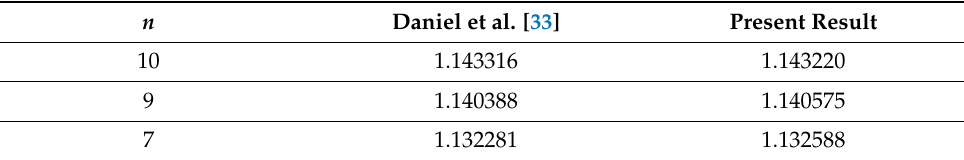
Table 3. Comparison of − f (cid:48)(cid:48) ( 0 ) when E 1 = 0, M = 0, A = 0, a 1 = 1, φ = 0, and α = 0.25 for changing values of n . n Daniel et al. [33] Present